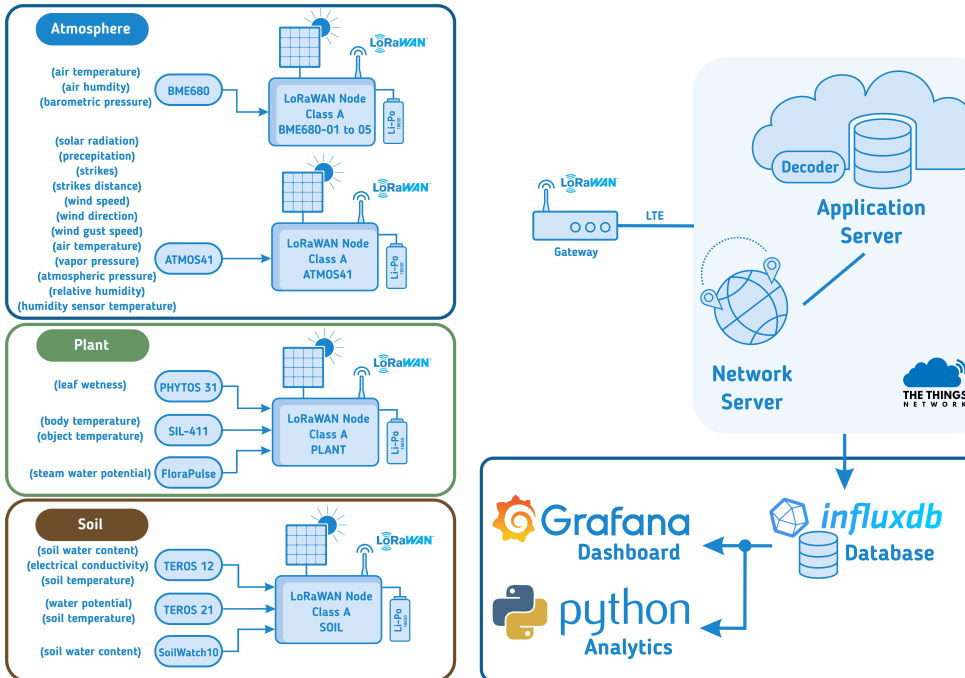
Figure 2. Graphical scheme of the implemented system.